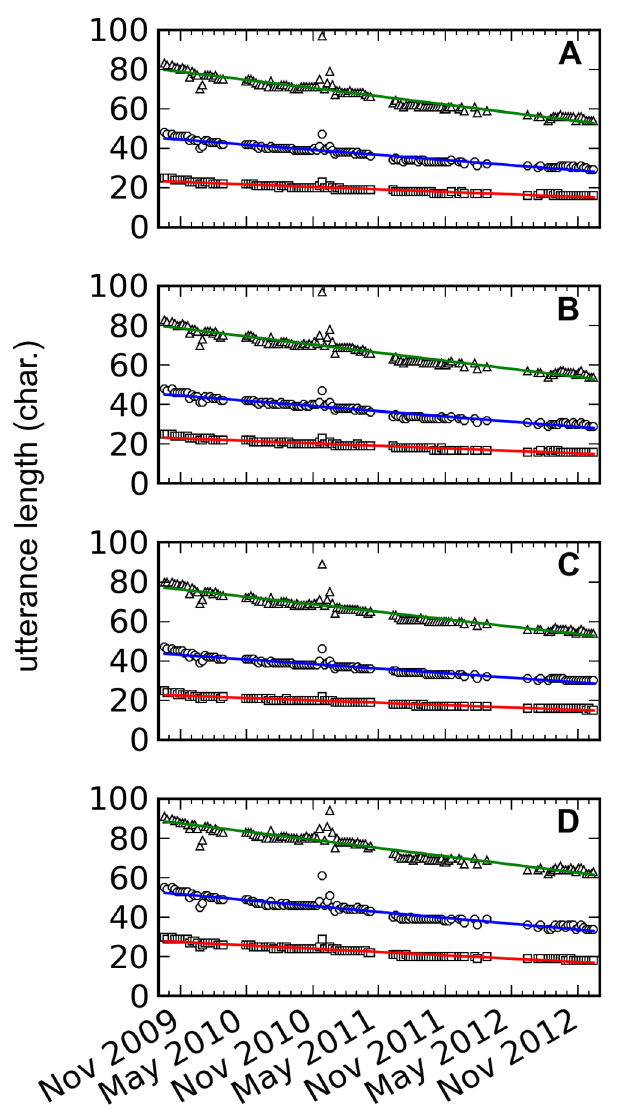
Figure 3. Utterance length distribution over time. First quartile Q1 (square), median Q2 (circle) and third quartile Q3 (triangle) of the A. original dataset, B. after resampling into 10 5 utterances per day, C. removing URLs and D. restricting to English tweets.